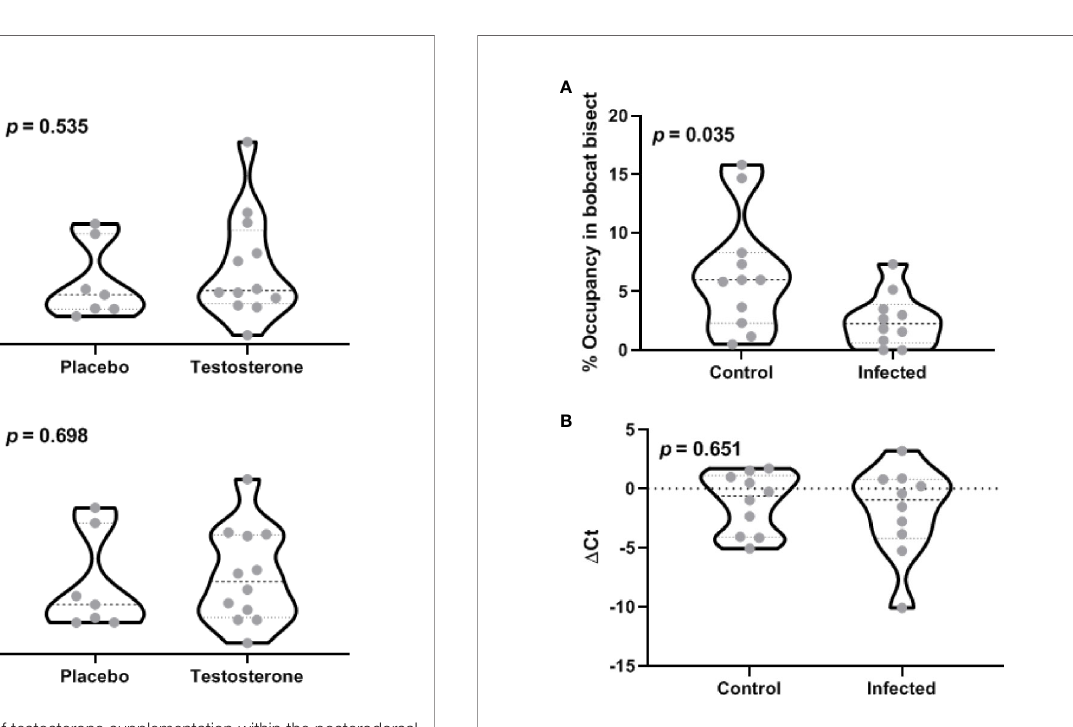
FIGURE 3 | Effects of castration after the chronic phase of Toxoplasma gondii infection on defensive behavior (A) and medial amygdala arginine vasopressin promoter methylation (B) . Violin plots in these panels depict median and inter-quartile range along with raw values for all data points (n = 11 animals for control and 12 for the infected group). The p -values for inter- group differences are depicted in each panel.